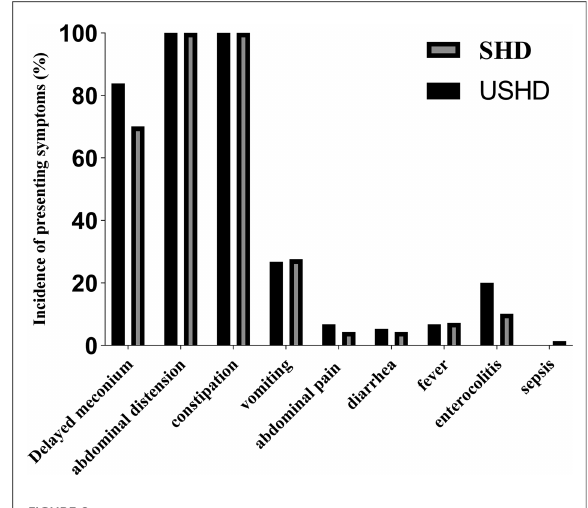
FIGURE 2 Difference in clinical mainfestaions between USHD and SHD group before